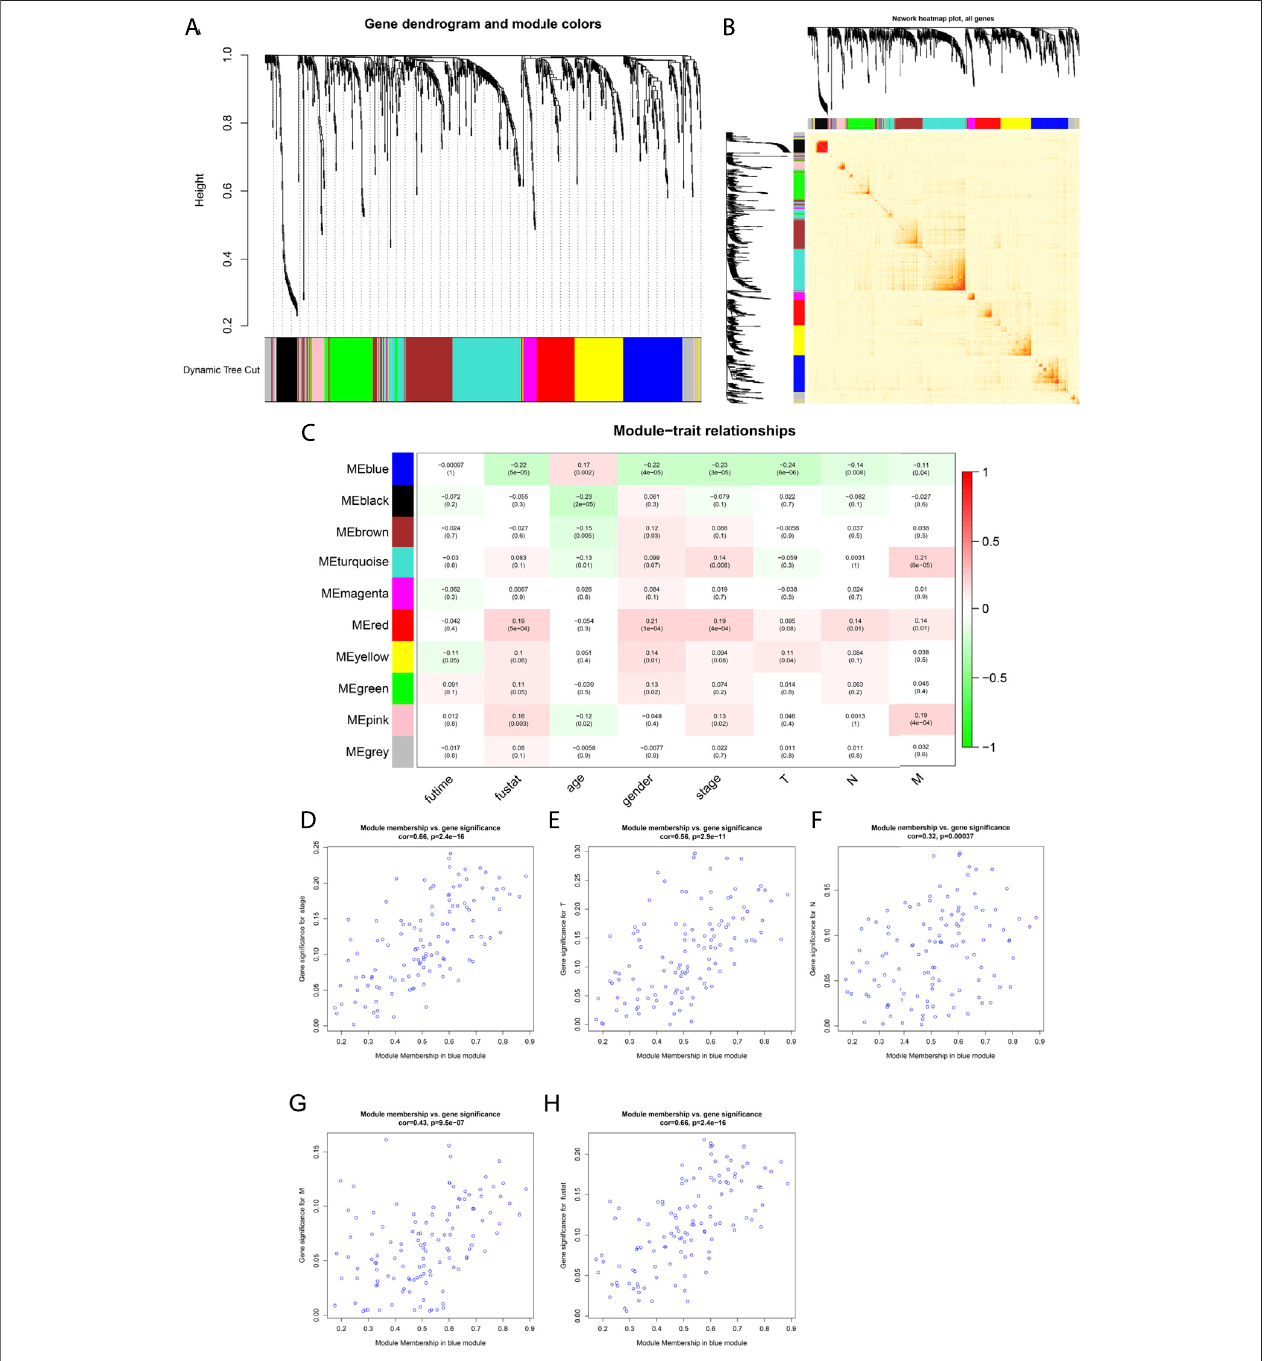
FIGURE4 | Weighted co-expressionnetworkconstruction and identi fi cation of thekey module containing CCL17. (A) Cluster dendrogram wasbuilt based on the dissimilarity of the topological overlap, which presents ten gene co-expression modules in LUAD; the gray module indicates no co-expression between the genes. (B) Heat map describes the TOM among selected 1,455 genes in WGCNA, and the darker color represents higher overlap, and the lighter color corresponds to lower overlap. (C) Heat map of the correlation between module eigengenes and clinical traits of LUAD patients. (D-H) Scatter plot of GS for clinical stages, TNM stage, and fustat vs. MM in the blue